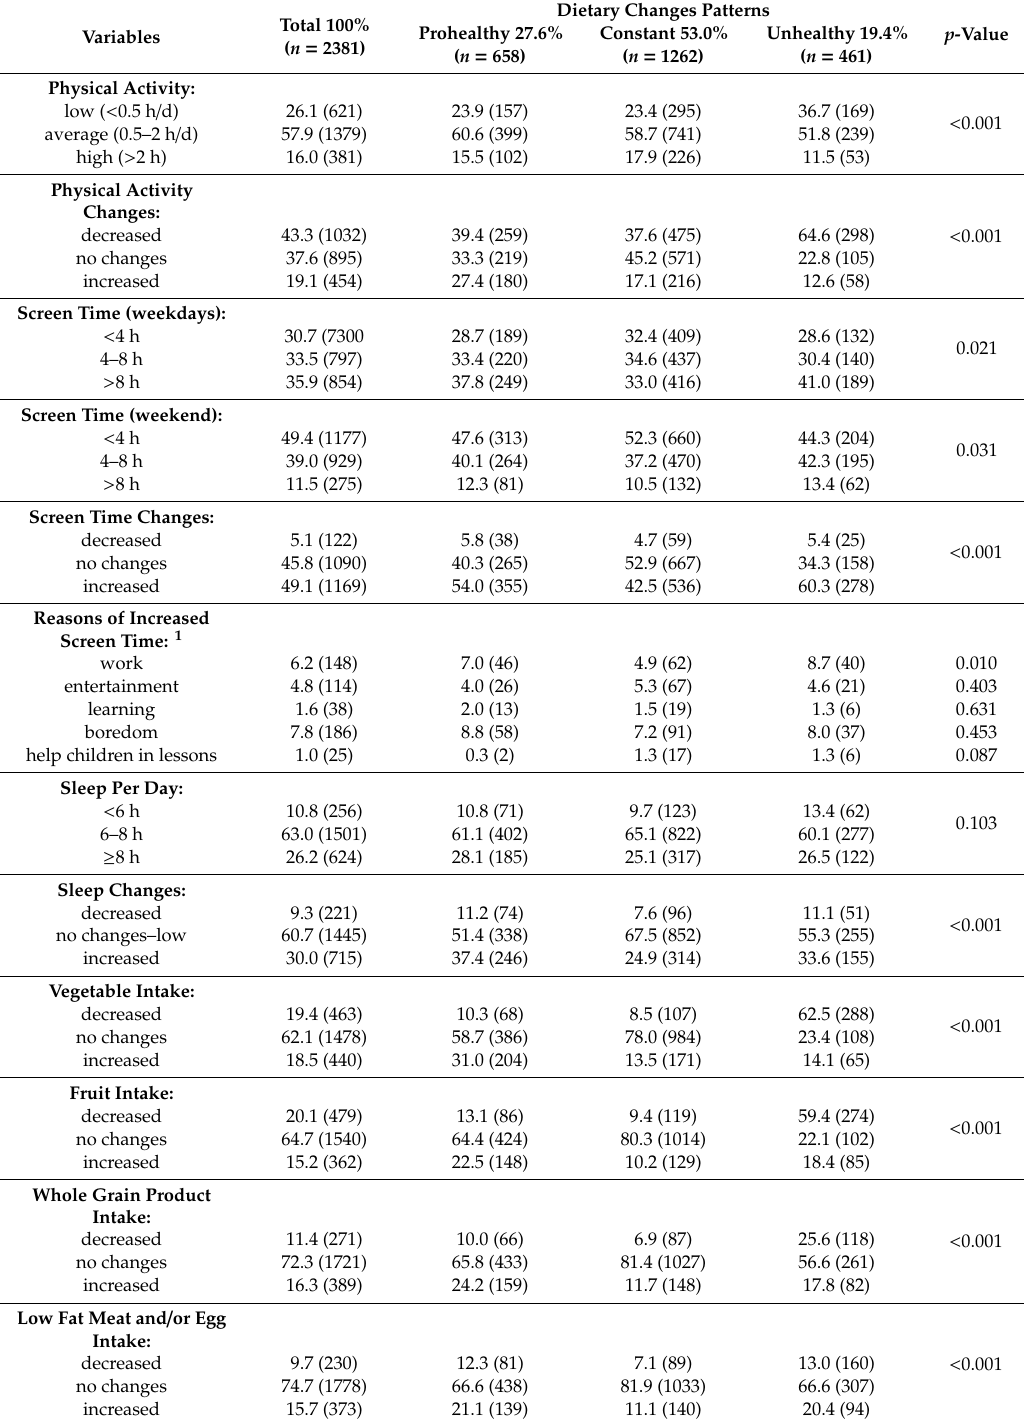
Table 2. Lifestyle and food intake changes according to dietary changes patterns during COVID-19 pandemic (% ( n